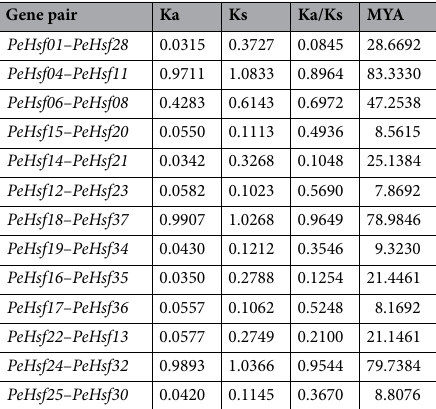
Gene pair Ka Ks Ka/Ks